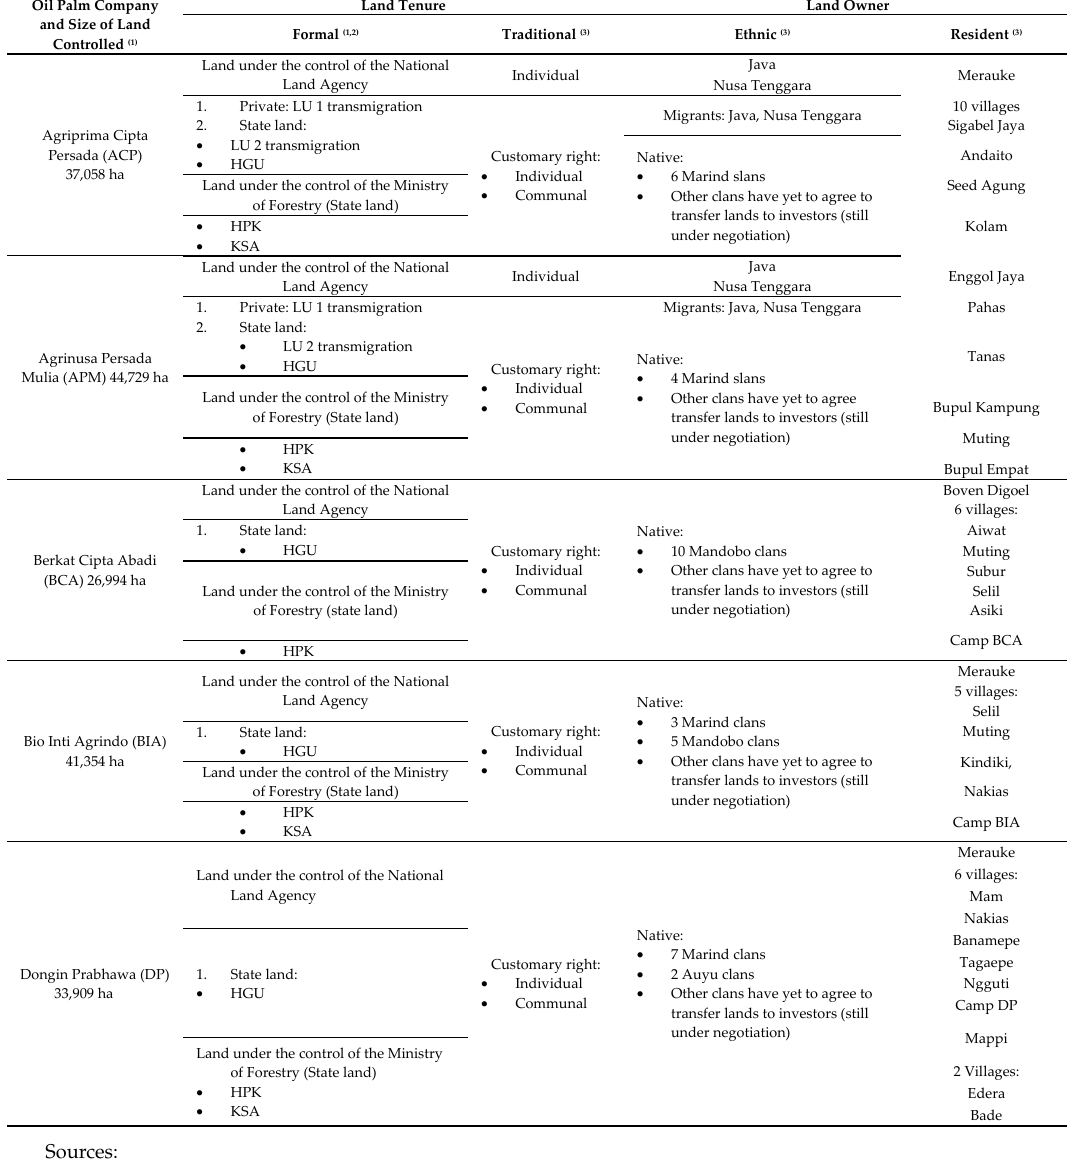
Table 1. Tenure and owners of lands occupied by five different oil palm companies. Oil Palm Company and Size of